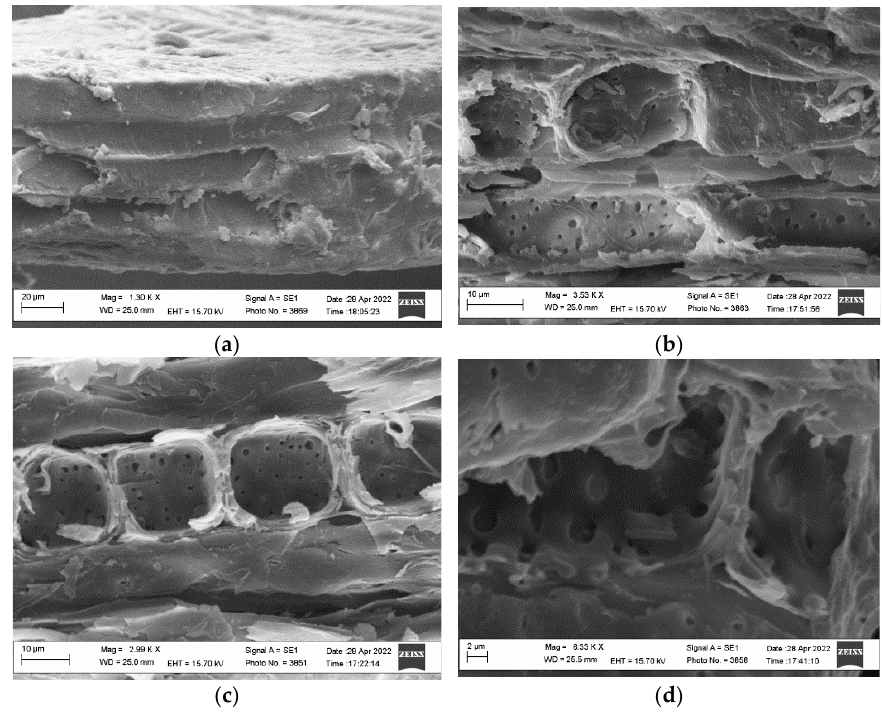
Figure 2. Micrographs attained for: ( a ) untreated biomass; ( b ) pretreated biomass with acetic acid (10 wt%); ( c ) pretreated biomass with HNO 3 (0.1 wt%)/H 2 SO 4 (0.1 wt%); ( d ) pretreated biomass with H 2 SO 4 (0.1 wt%).